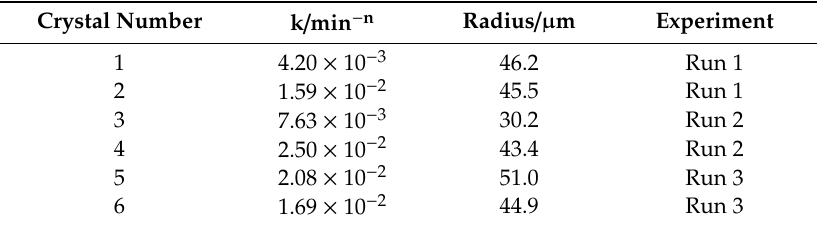
Table 3. Formation rate constants of the Fujii and Kondo equation obtained from the di ff usion-controlled step for six crystals (the radius of the crystals was obtained from the microscopic images of crystals and determined with the software